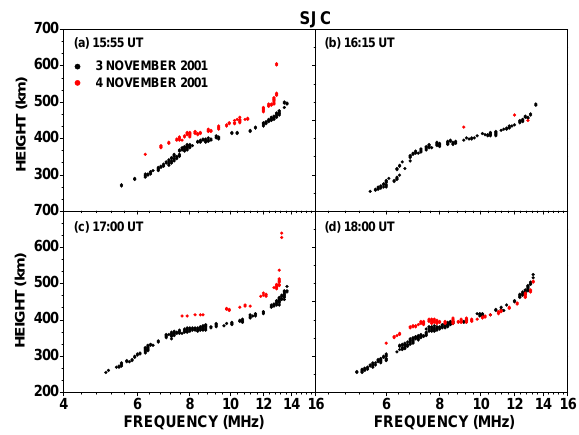
Fig. 7. The ionograms obtained at (a) 15:55 UT, (b) 16:15 UT, (c) 17:00 UT and (d) 18:00 UT on 3 November 2001 (normal day; black dots) and 4 November 2001 (solar flare day; red dots) at SJC. This period covers the ionograms obtained with partial radio-wave absorption at 15:55, 17:00, and 18:00 UT and complete absorption at 16:15